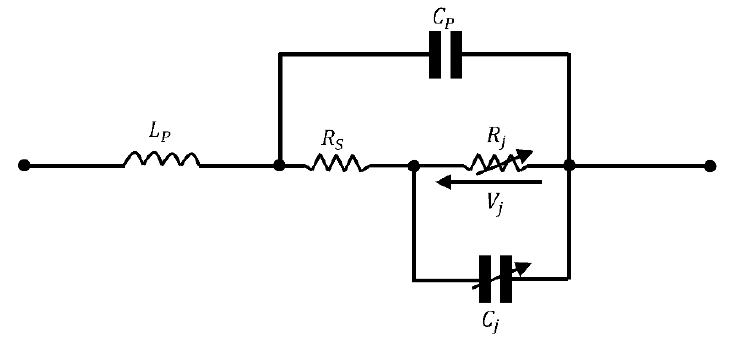
Figure 6. Small signal model of Schottky diode.